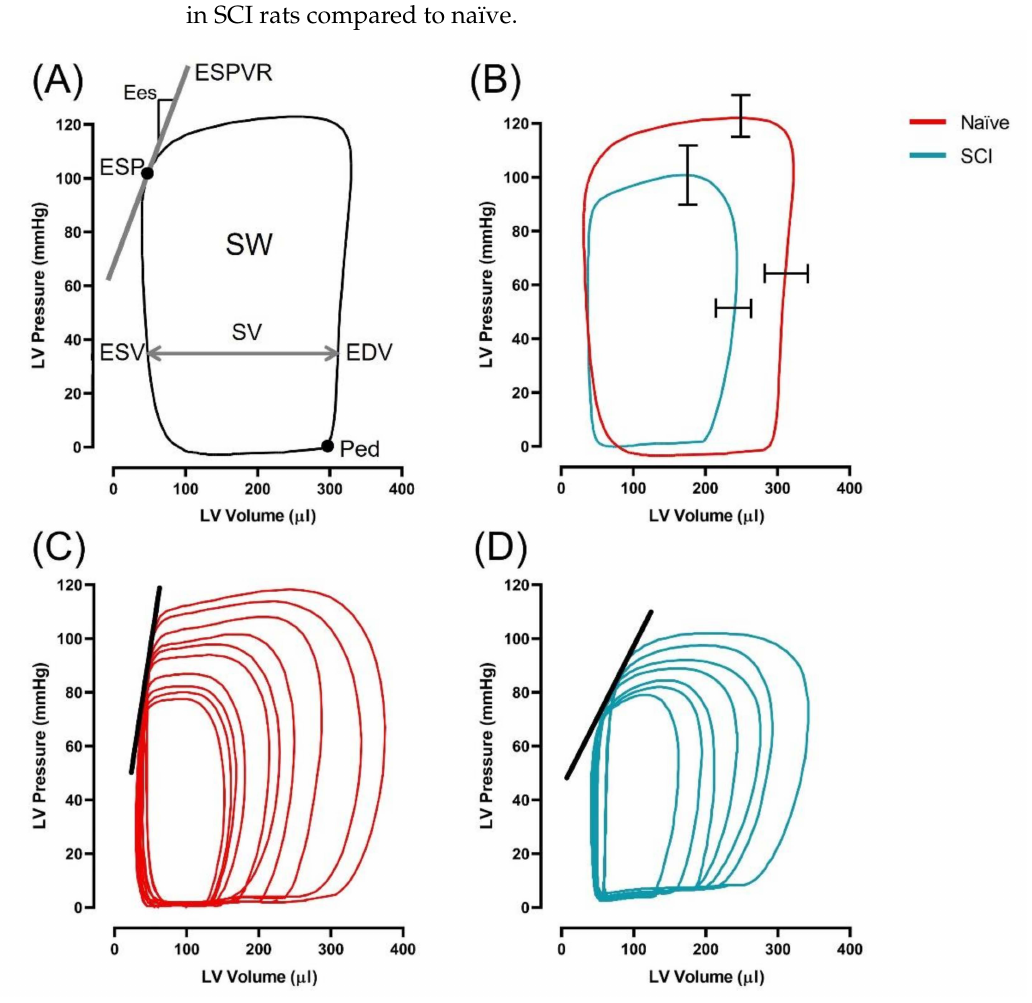
Figure 4. At 2 weeks post-SCI, animals underwent left ventricular catheterization to assess cardiac function. Pressure- volume analysis revealed reduced pressure, volume, and contractile function among SCI compared to naïve rats. ( A ) An example pressure-volume loop labelled with relevant indices acquired from pressure-volume analysis (ESV; end-systolic volume, EDV; end-diastolic volume, Pes; end-systolic pressure, Ped; end-diastolic pressure, SV; stroke volume, SW; stroke work (area of the pressure volume loop), ESPVR; end systolic pressure volume relationship, Ees slope of ESPVR). ( B ) Example basal pressure volume loop from SCI and naïve rats, overlaid with SEM bars, demonstrating diminished LV maximum pressure (22 ± 4 mmHg; p < 0.001) and EDV (50 ± 15 ul; p = 0.002) in SCI compared to naïve animals. C-D: Example inferior vena cava occlusions from naïve ( C ) and SCI ( D ) groups demonstrating reduced Ees among SCI compared to naïve animals (0.7 ± 0.1 mmHg/ul; p <